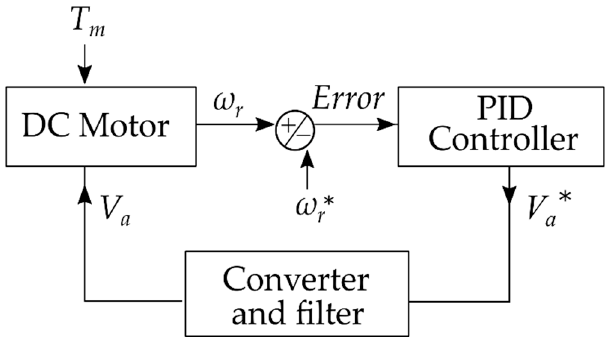
Figure 2. Block diagram of the DC motor drive system